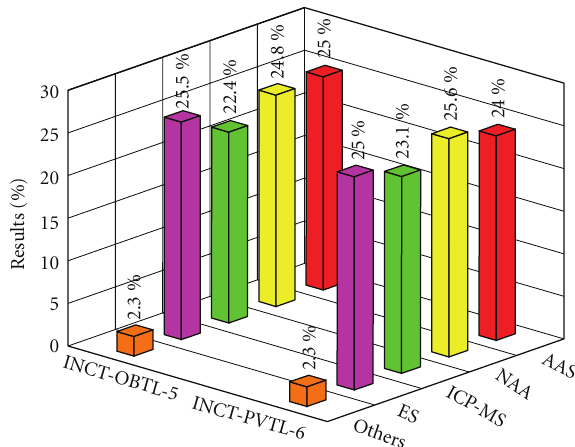
Figure 8: The share of analytical techniques in the certification pro- cess of INCT-OBTL-5 and